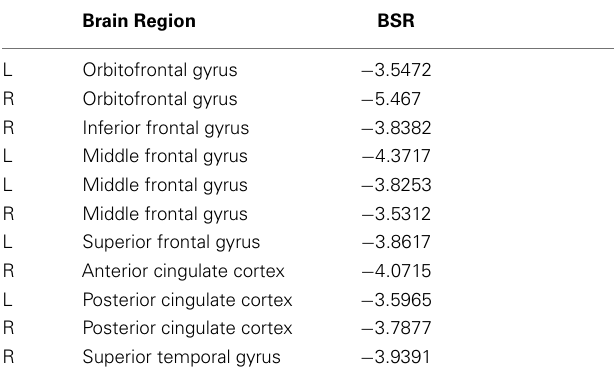
Table 3 | Brain regions comprising the pattern of SPECT perfusion that significantly differentiatesTBI patient groups from the MDD group, using mean-centered partial least squares .